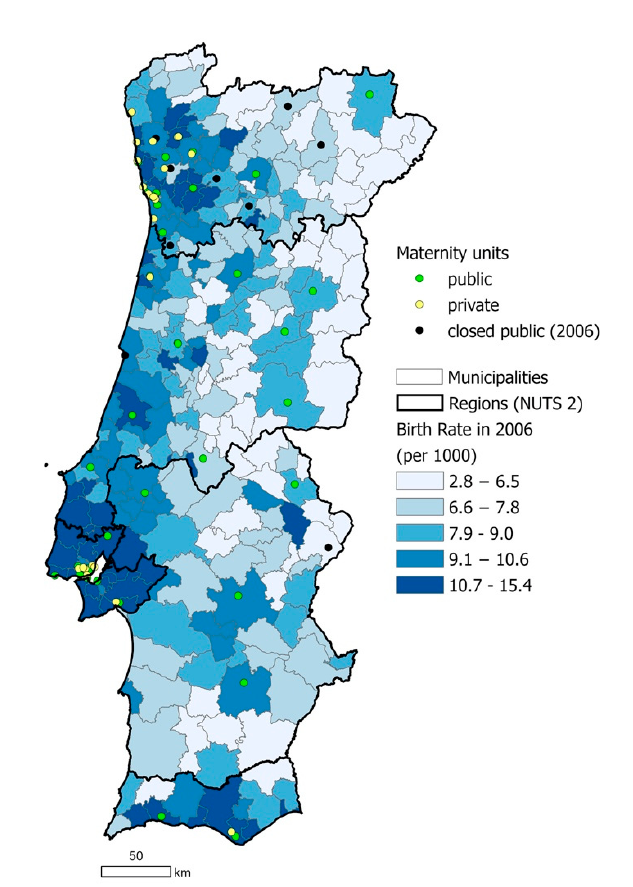
Figure 2. Location map of running and closed public maternity units and running private maternity units, as well as birth rate by municipality, in Portugal in 2006. Source: based on data retrieved from the National Institute of Statistics portal [26], the NHS portal [24] and Birth Advisor portal [25]. Geographic accessibility to public maternity units in Portugal by car was